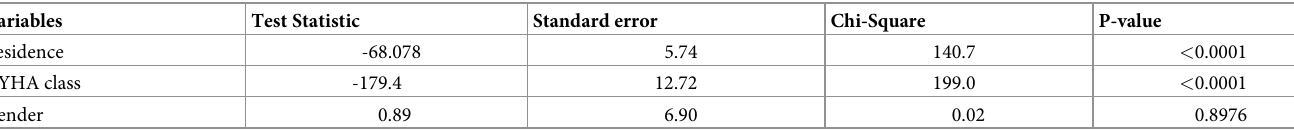
Table 4. Results of the log-rank test for categorical variables.